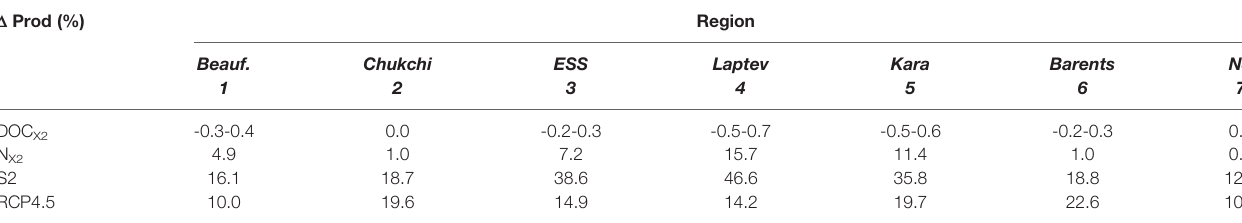
TABLE 5 | Estimated impact of environmental variables on annual primary production in the Arctic regional seas. D Prod (%) Region